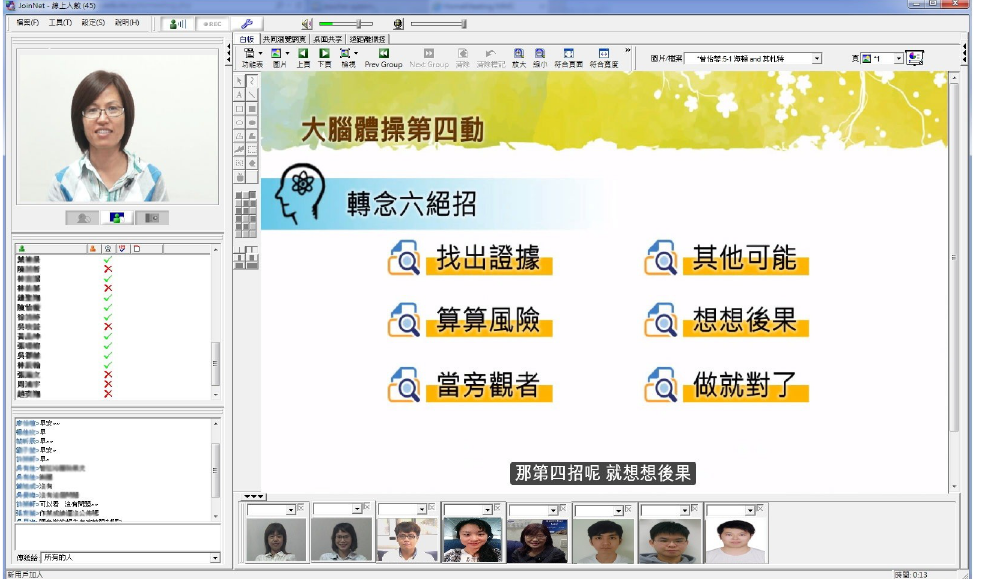
Fig 2. Online synchronous video conference with all the videos of